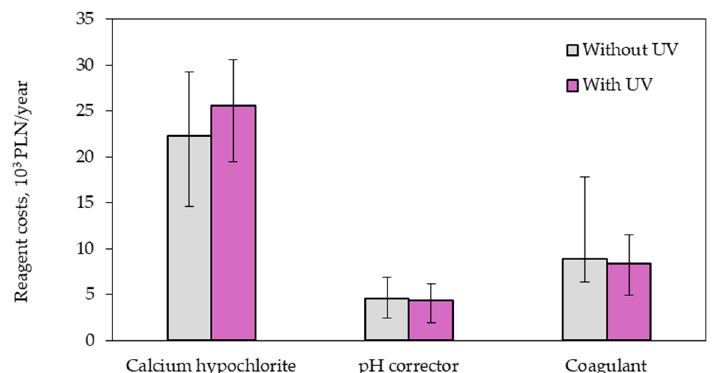
Figure 3. The costs of reagents consumed to treat swimming pool water for the two variants of the installation operation—without and with UV lamp (costs are given in thousands of PLN, PLN 1 = EUR